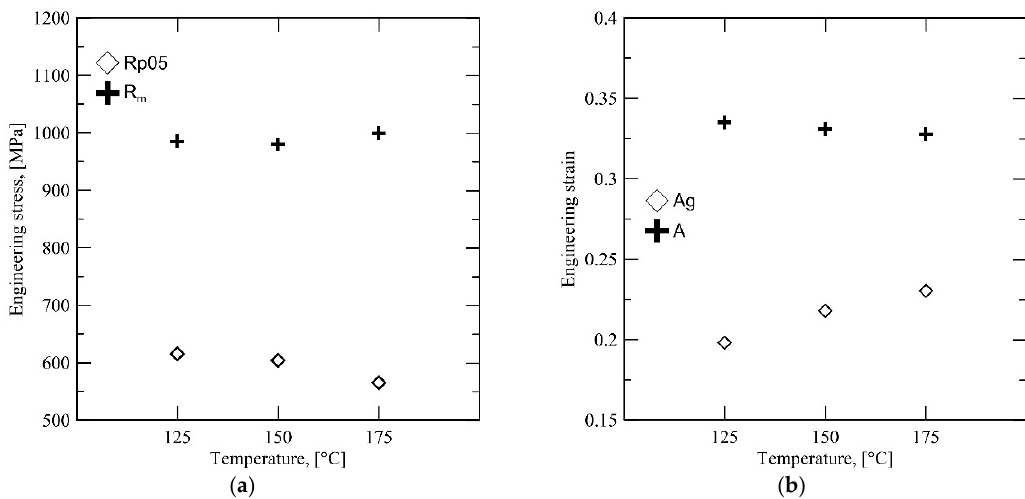
Figure 7. ( a ) The measured 0.5% proof strength and R m values for Steel A with respect to QT . ( b ) The uniform elongation Ag and total elongation A for Steel A with respect to QT . Specimens annealed at 850 °C, quenched to QT and partitioned at 450 °C for 100 s.